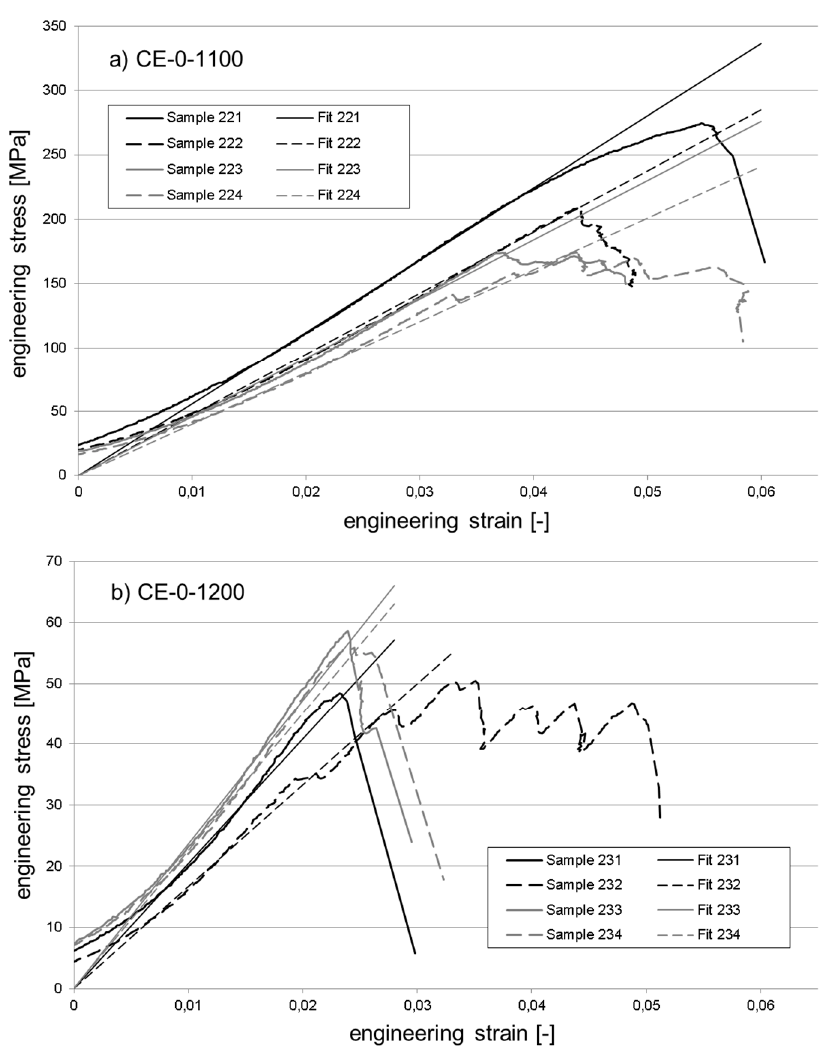
Figure 10. Exemplary stress strain curves for the reference material containing no cenospheres: ( a ) maximum strength at firing temperature 1100 °C; ( b ) strength and stiffness reduction at firing temperature 1200 °C.